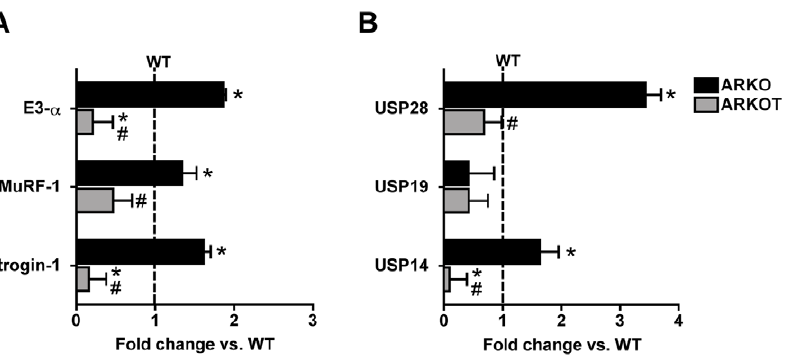
Figure 3. mRNA levels of UPS components. mRNA levels of E3 ligases E3- a , MuRF-1 and Atrogin-1 (A), and deubiquitinating enzymes USP28, USP19 and USP14 (B). WT values were arbitrarily set to 1.0 and are represented by the dashed line. Data are shown as fold change over wild type control group and presented as mean 6 standard error from mean. *p , 0.05 vs. WT; # p , 0.05 vs. age-matched ARKO.